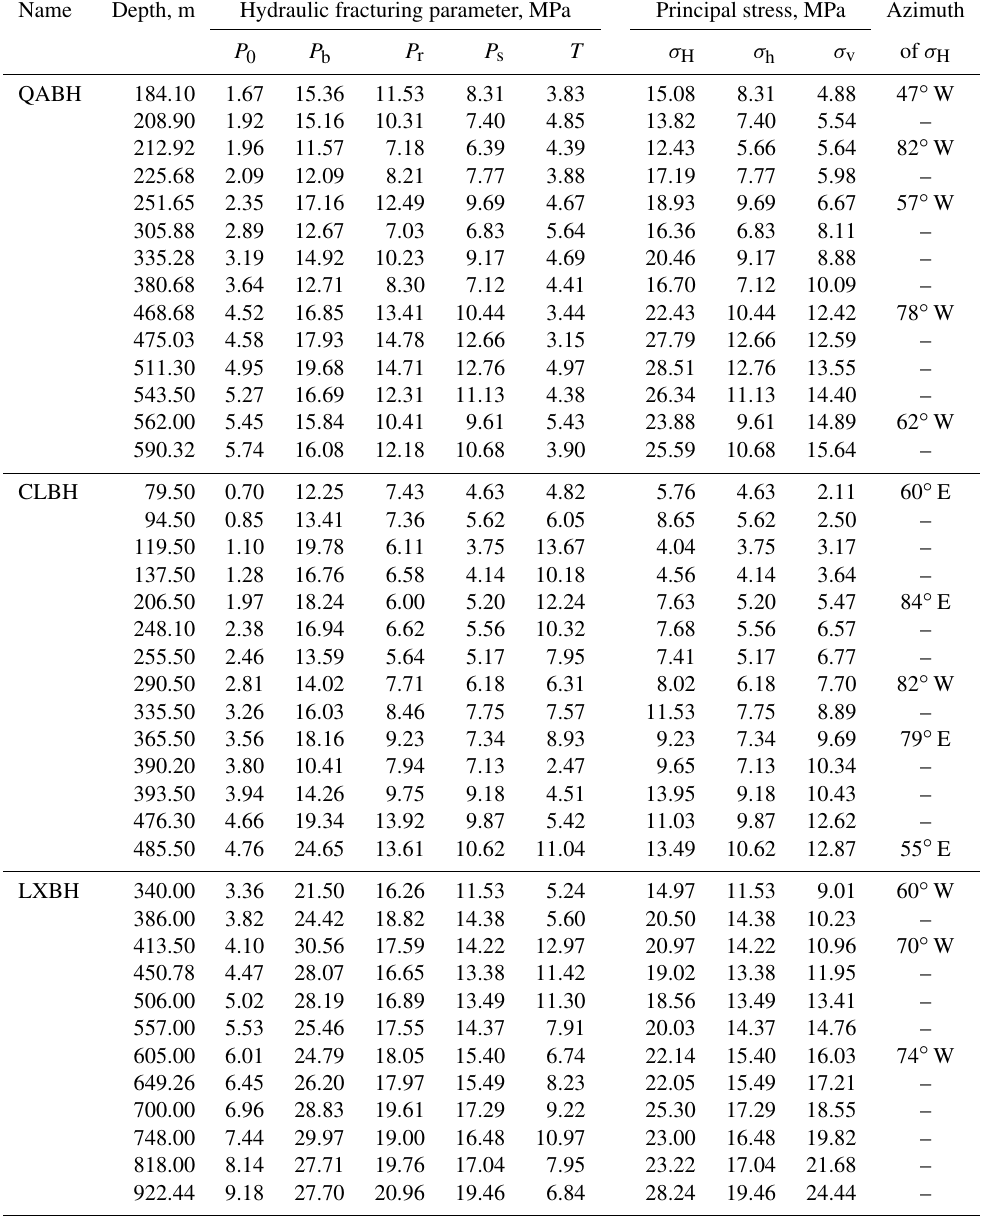
Table 2. Hydraulic fracturing in situ stress results at QABH, CLBH, and LXBH boreholes near the MTY EGS field.